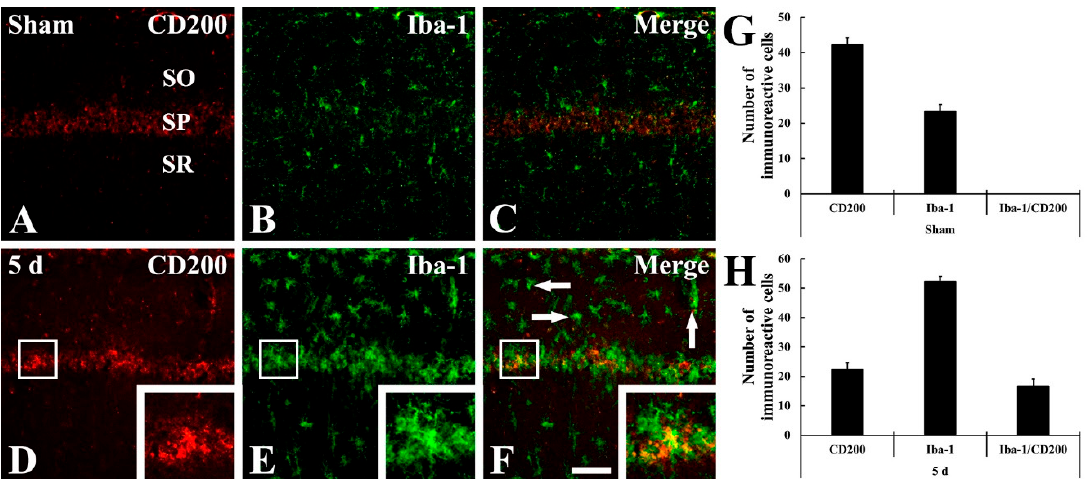
Figure 6. ( A – F ) Double immunofluorescence staining for CD200 (red, ( A , D )), Iba-1 (green, ( B , E )), and merged images ( C , F ) in the CA1 field of the sham group ( A – C ) and ischemia group ( D – F ) at 5 days after tFI. CD200 immunoreactivity is not observed in Iba-1-positive microglia of the sham group, whereas CD200 immunoreactivity is shown in Iba-1-positive microglia (arrows) at 5 days after tFI. Scale bar = 50 µm. ( G , H ) Analyses of the numbers of CD200 immunoreactive cells, Iba-1 immunoreactive microglia, and Iba-1 immunoreactive microglia among CD200 immunoreactive cells in the sham group ( G ) and ischemia group ( H ).